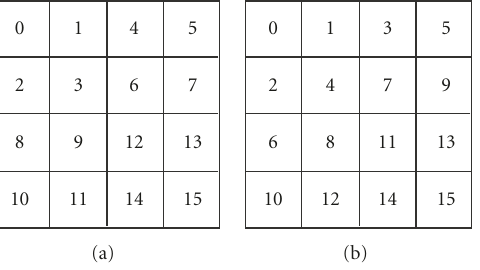
Figure 3: The processing order of 4 × 4 intraprediction. (a) Original order, (b) optimal order minimizing the cost of